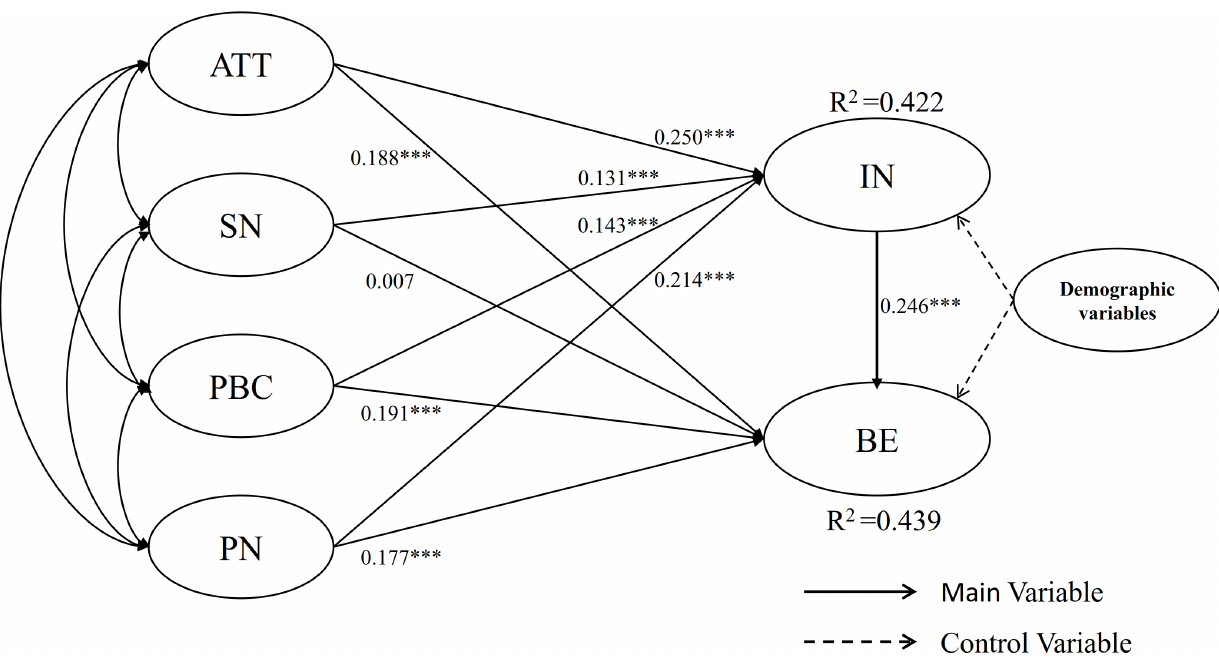
FIGURE 2 | Results of the structural equation model. (1) ATT, attitudes; SN, subjective norms; PBC, perceived behavioral control; PN, personal norms; PPE, perceived policy effectiveness; IN, users’ civilized cycling intention; BE, users’ civilized cycling behavior; (2) ∗ p < 0.05, ∗∗ p < 0.01, ∗∗∗ p <